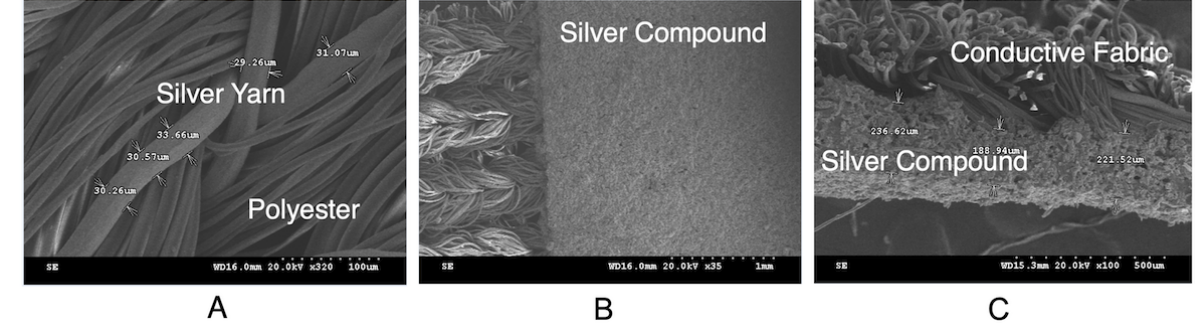
Figure 5. Scanning electron microscope images of textile electrode. A. Knitted textile electrodes without silver compound coating (320× magnification). B. Knitted textile electrodes with silver compound coating (35× magnification). C. Cross-section of knitted textile electrodes with silver compound (100× magnification).